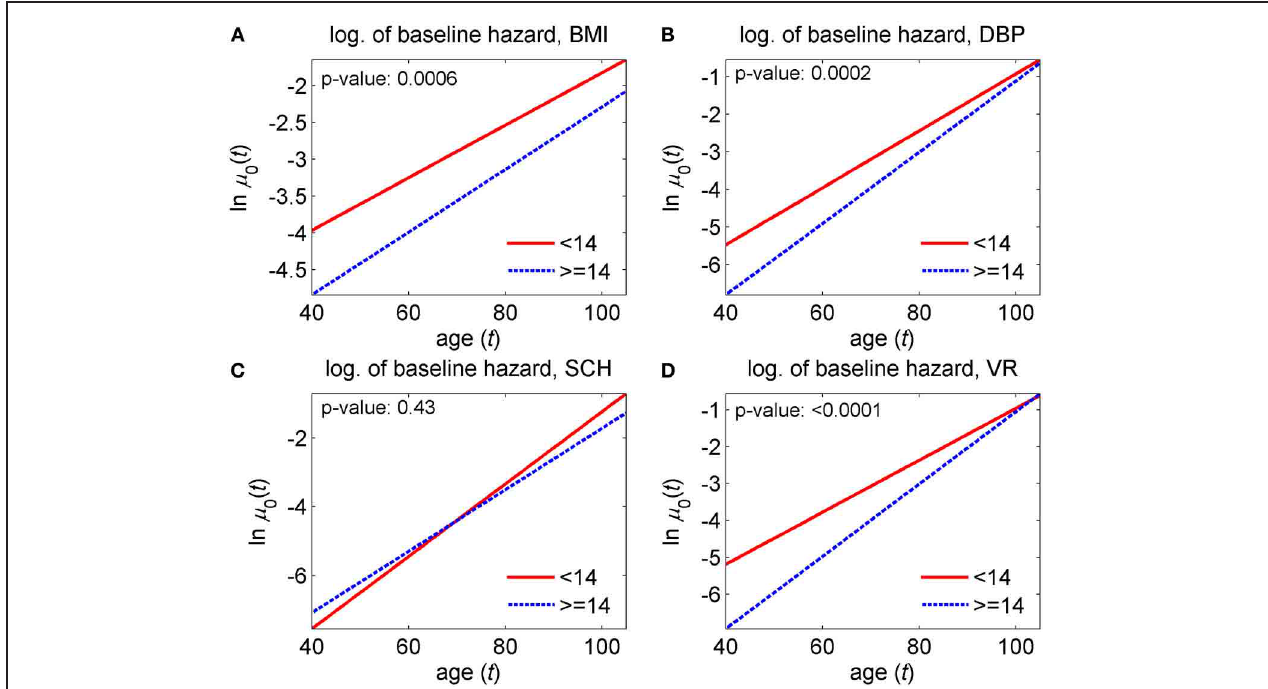
(2012c). (A) Estimates for body mass index (BMI); (B) estimates for diastolic blood pressure (DBP); (C) estimates for cholesterol (SCH); (D) estimates for ventricular rate (VR). P -values are for the null hypotheses on the equality of baseline hazards in the two groups. See more details about the model in section “Advanced statistical analyses using the stochastic process